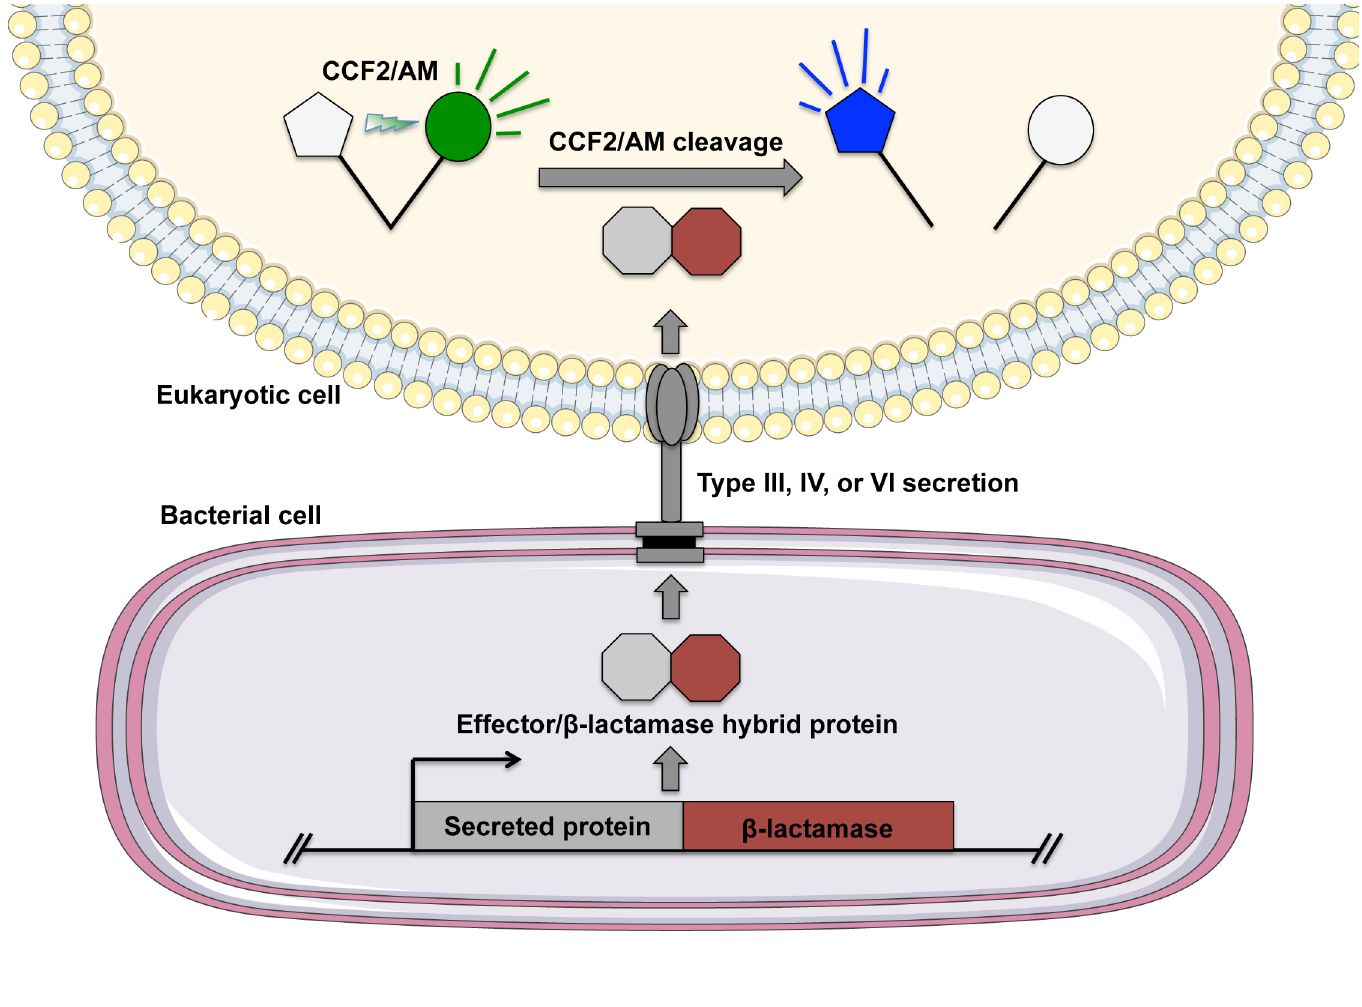
Fig 1. Evaluating bacterial secretion using the FRET-based substrate CCF2/AM. To monitor bacterial secretion, the gene encoding a β -lactamase is cloned in-frame with a portion of the gene encoding a predicted secreted protein to generate a translational fusion. Eukaryotic cells are infected with the bacteria harboring the fusion protein, followed by incubation of infected cells with the fluorescent substrate CCF2/AM (or its analog CCF4/AM). CCF2/AM consists of 7-hydroxycoumarin and fluorescein connected with a cephalosporin linker. Cells can then be examined by flow cytometry, fluorescence microscopy, or using a plate reader in a multiwell format. Under excitation at 405 nm, the 7-hydroxycoumarin and fluorescein moieties of CCF2/AM exhibit FRET, and emission is detected from the acceptor fluorescein as green fluorescence (520 nm). If the target cell has undergone translocation and harbors the bacterial fusion protein, the cephalosporin linker is cleaved by β -lactamase, which disrupts FRET and results in blue fluorescence from 7-hydroxycoumarin at 447 nm.